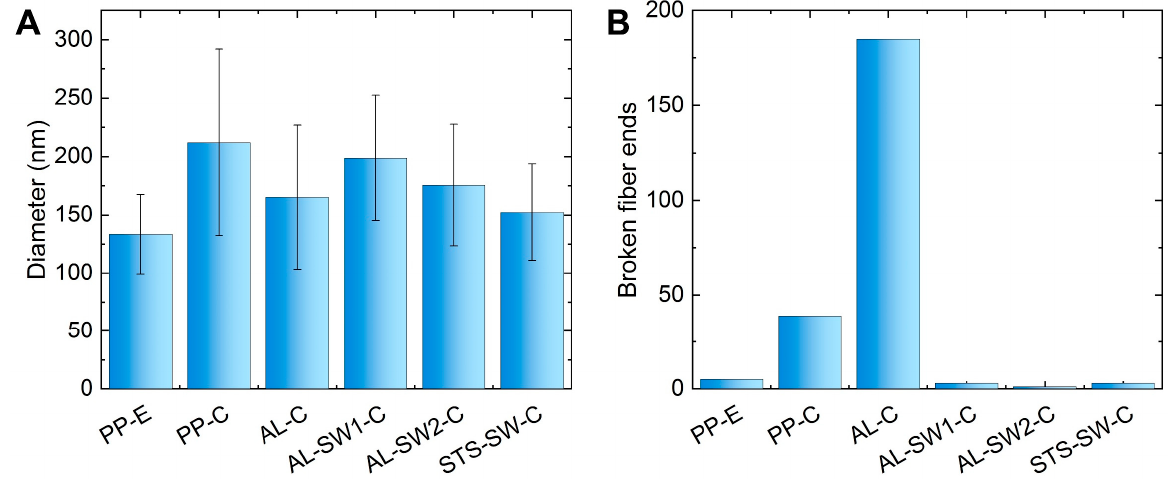
Figure 2. Evaluation of HIM images: ( A ) average diameters and ( B ) approximate numbers of broken fiber ends per image.